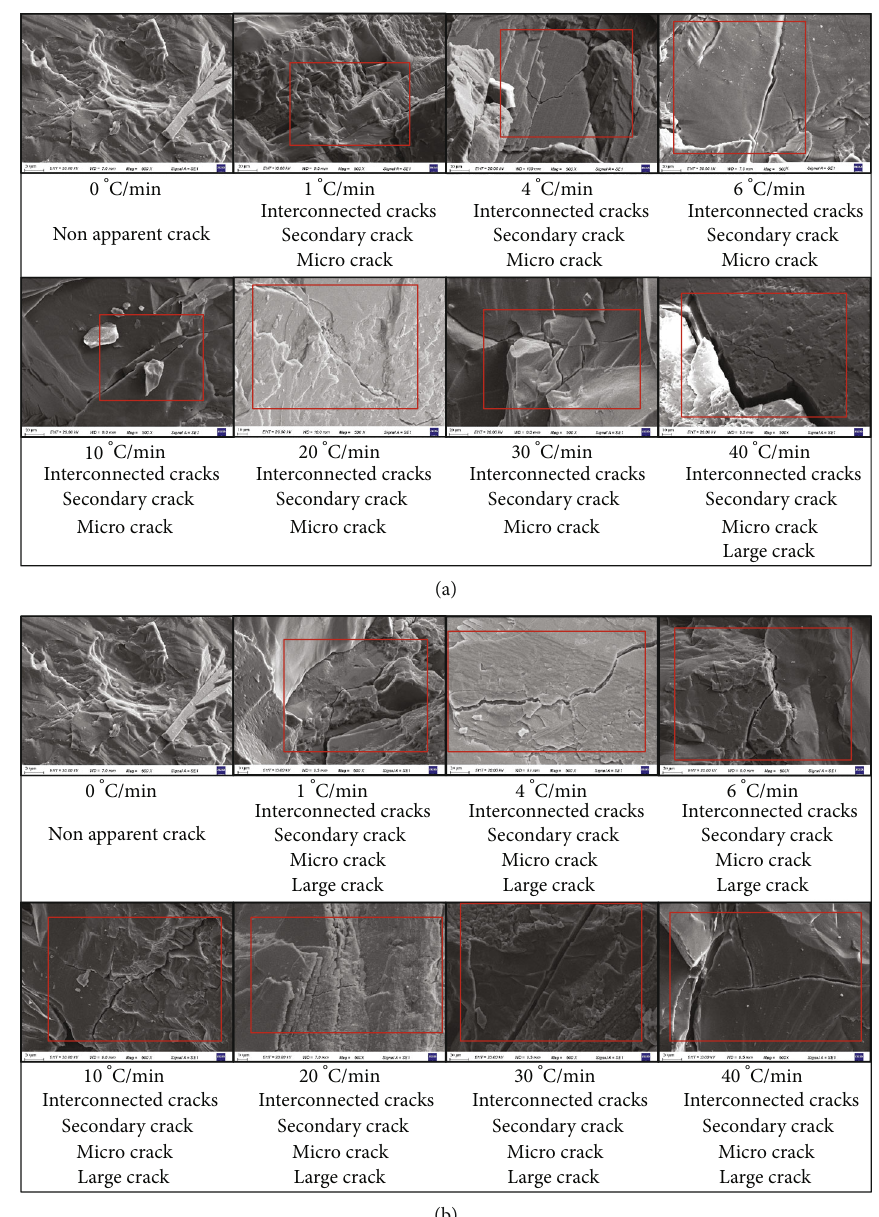
Figure 4: The internal structures of thermal shock treated granite specimens (a) T = 400 ° C and (b) T = 600 ° C